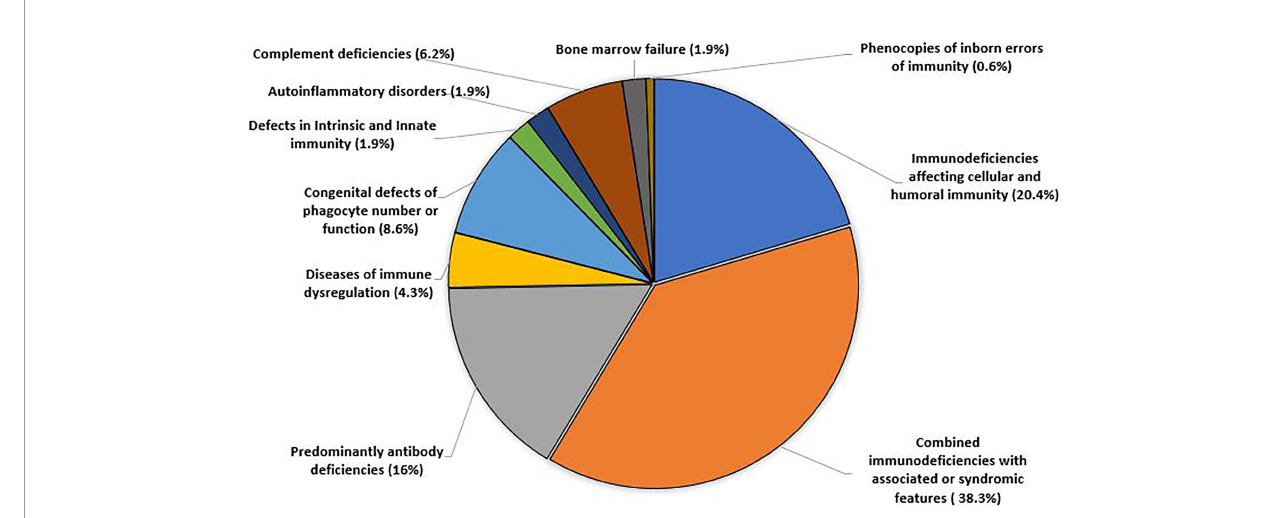
FIGURE 1 | The percentages (distribution) of 162 patients according to IEI